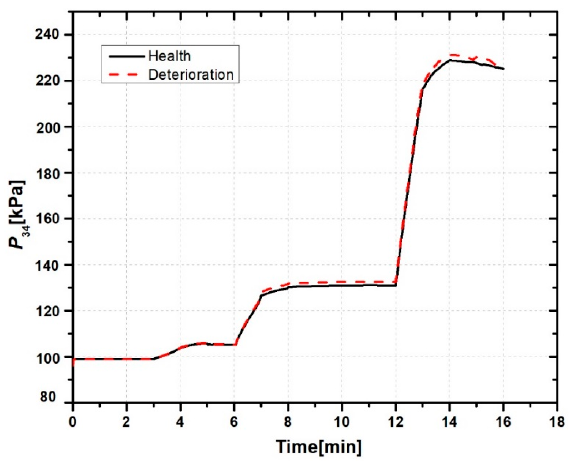
Figure 9. Simulation result of the high-pressure turbine discharge pressure.